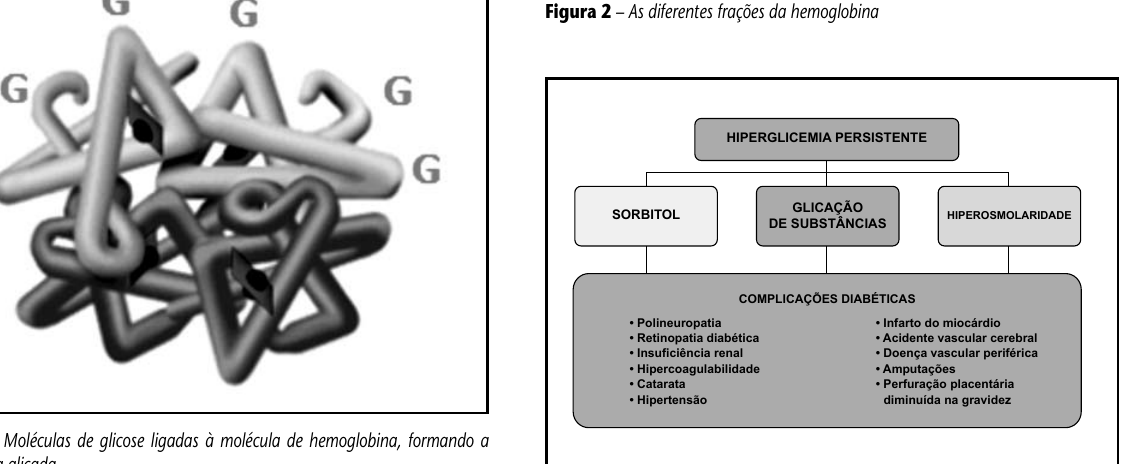
Figura 2 – As diferentes frações da